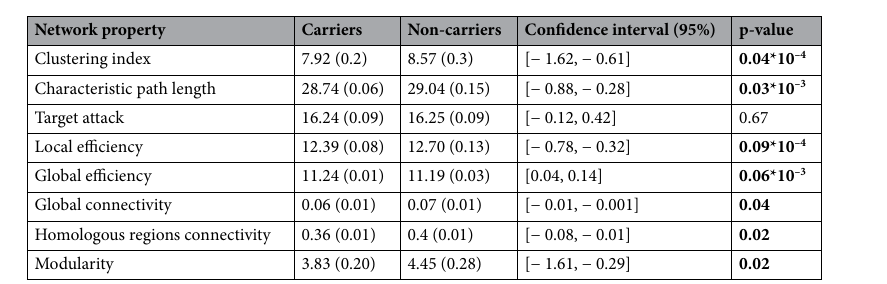
Table 2. Network properties differences between groups. Network properties in each group are represented by the mean and standard deviations: mean (s.d). In bold, the significance differences, those confidence intervals that do not contain